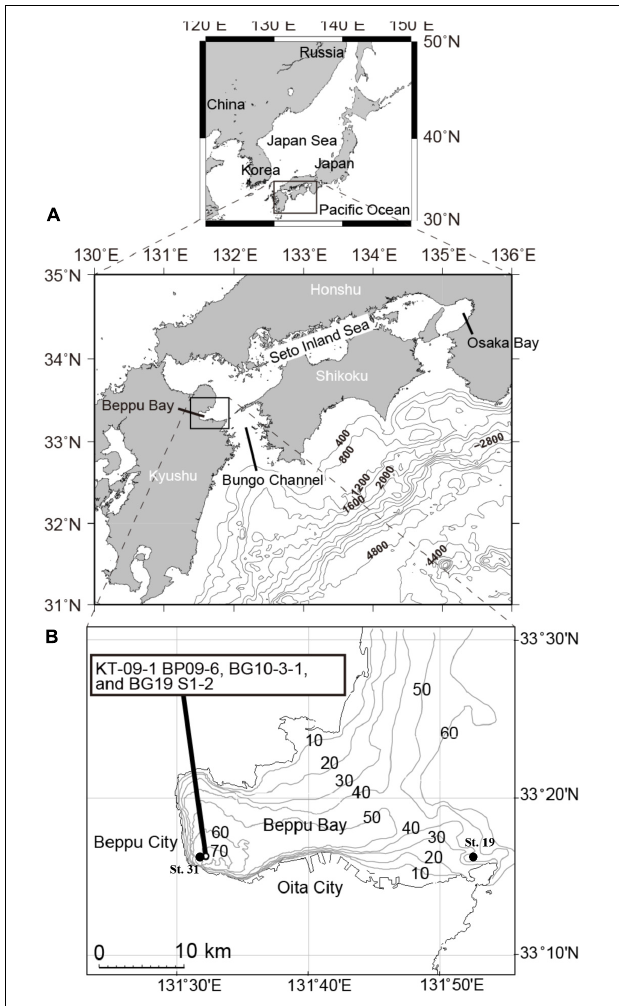
FIGURE 1 | (A,B) Sampling location map and operation points for the shallow sea constant line survey (Senkai Teisen Chosa (STC) in Japanese) carried out by the Oita Prefectural Fisheries Research